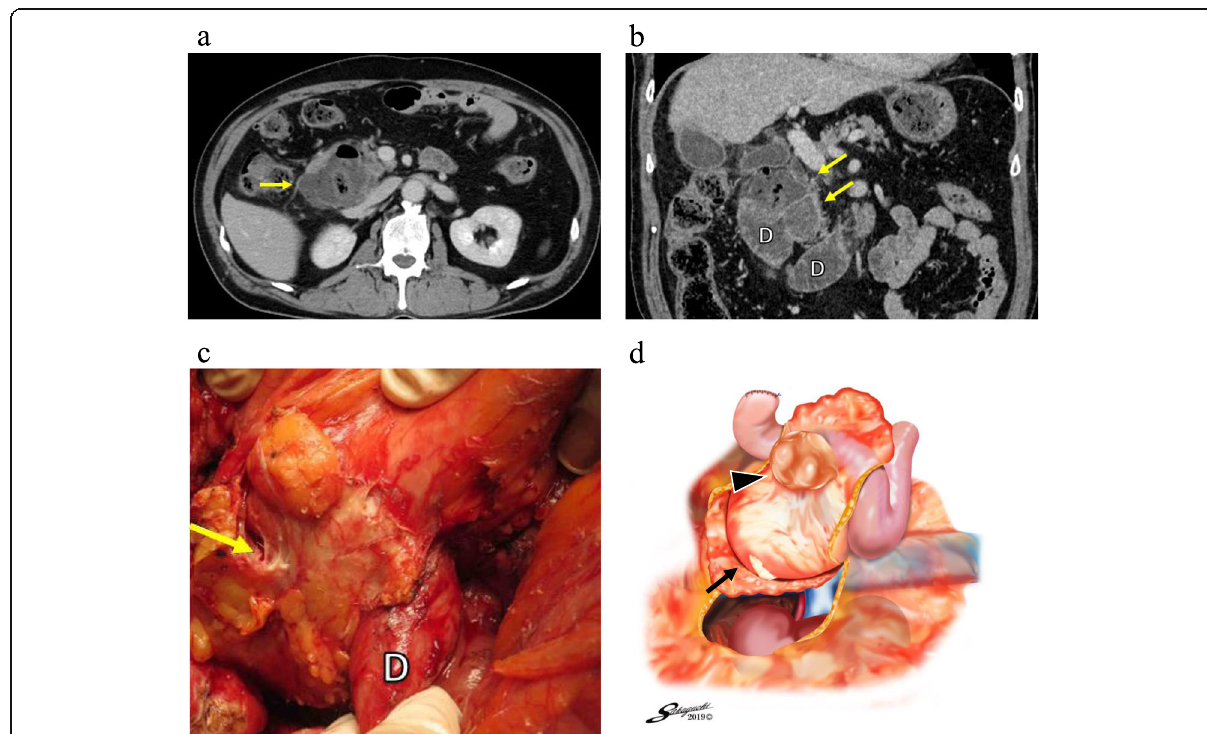
Fig. 2 Computed tomography of case 1 with a perforated duodenal diverticulum and surgical findings. Abdominal contrast-enhanced CT ( a , axial plane) showed an extraluminal fluid collection with gas (yellow arrow) surrounding the duodenum. Coronal plane ( b ) showed that an abscess (yellow arrows) was suspected around the second and third parts of the duodenum (D). A retroperitoneal abscess (yellow arrow) behind the second part of the duodenum (D) was found after performing Kocher maneuver ( c ). The schema ( d ) showed that a white-yellow retroperitoneal abscess (black arrow) was seen behind the perforated duodenal diverticulum (black arrowhead). And the right kidney was seen after performing Kocher